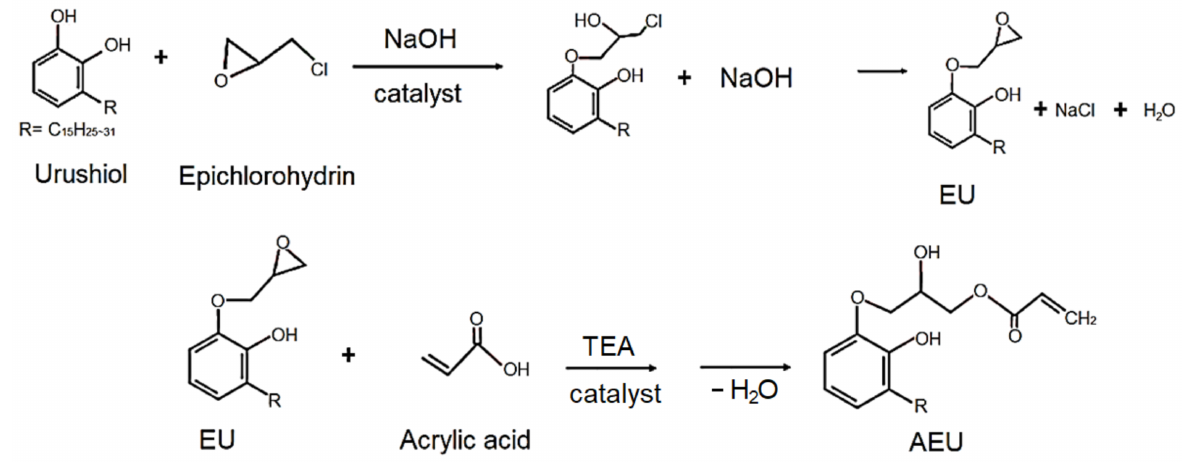
Figure 1. Syntheses of the epoxide urushiol (EU) and acrylic epoxide urushiol